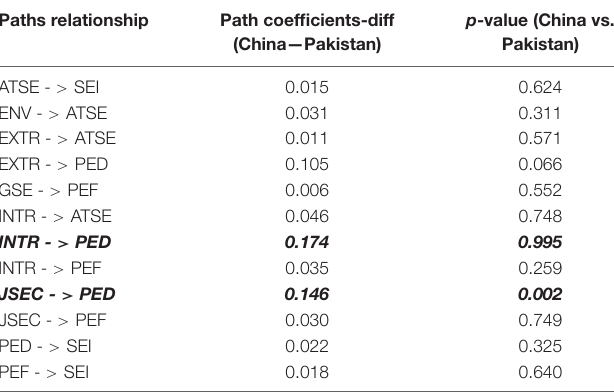
TABLE 11 | PLS-multigroup analysis of China vs.